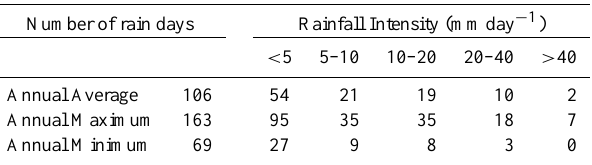
Table 1. Rainfall statistics for 1889–2006 in Southern River catch- ment showing number of rain days per year; annual average rainfall in the area is 891mm, maximum and minimum recorded annual rainfall are 1371mm and 499mm respectively.